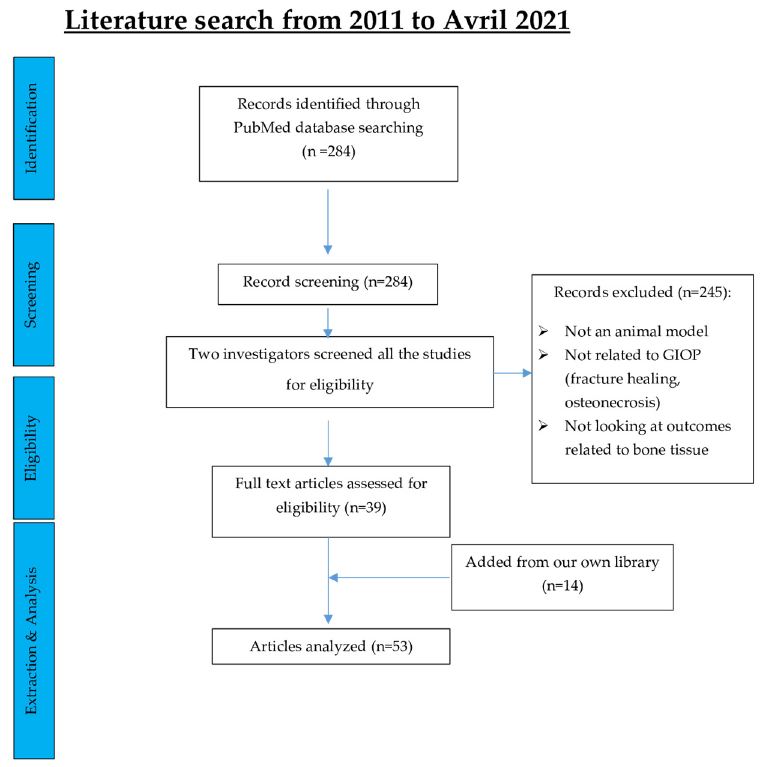
Figure 1. Flowchart illustrating the study selection process .